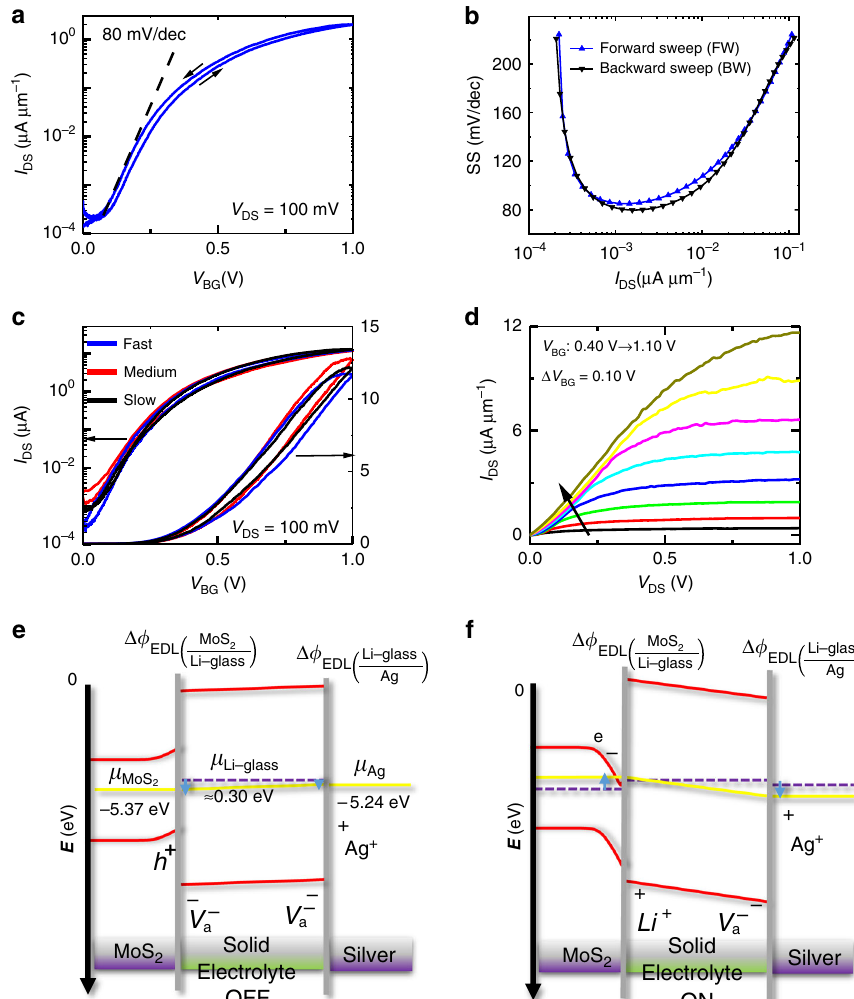
Fig. 2 Electrical transport characteristics of monolayer CVD MoS 2 transferred onto Li-ion glass. a Transfer characteristics of a back-gated CVD MoS 2 FET ( L = 1 µ m, W = 5 µ m). V TH is ~0.4 V. b SS vs. I DS for the same FET. SS calculated at points in the sub-threshold region of a . SS min for forward and backward sweeps are ~85 mV/dec and 80 mV/dec, respectively. c Transfer characteristics at different gate sweeping speeds. Sweeping rates for fast, medium, and slow sweeps are 44 mV s − 1 , 9 mV s − 1 , and 1 mV s − 1 , respectively. d Output characteristics of the FET at various back-gate voltages. e , f Schematics illustrating the band diagram for ON/OFF states of MoS 2 FET. Purple dashed and yellow solid lines represent the initial and fi nal states of the chemical potentials, respectively (see Supplementary Fig. 16 for further